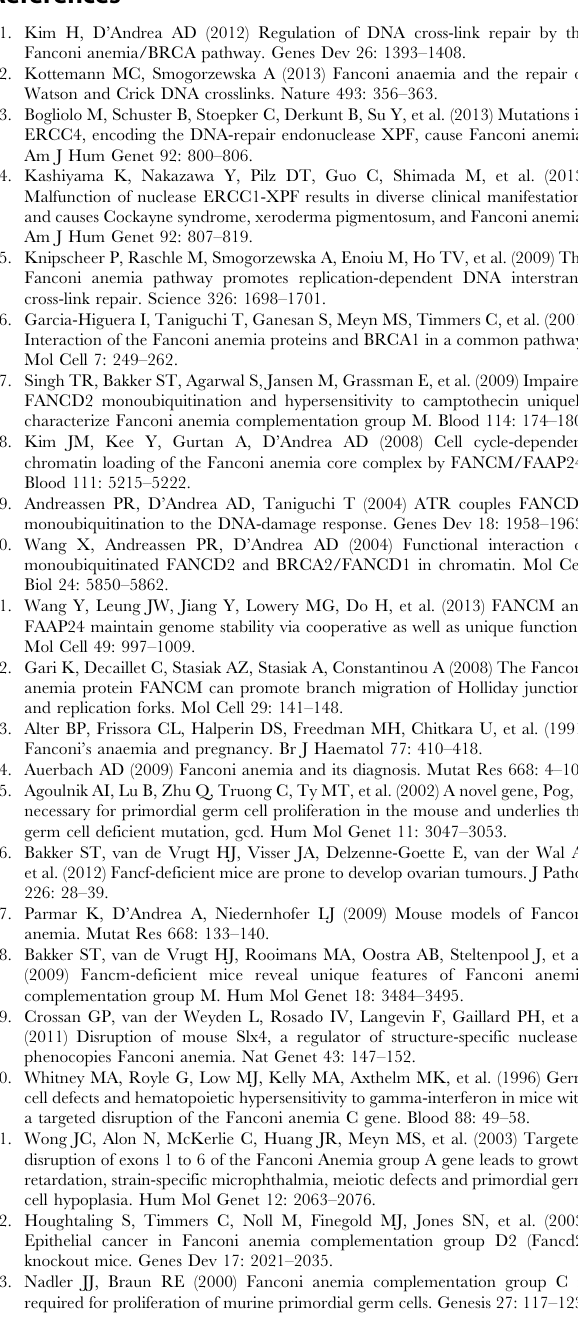
Figure S2 Representative images for PGC quantification and proliferation in E13.5 embryonic gonads. Wild type (A, C) and Fancm C4/C4 (B, D) male (A, B) and female (C, D) gonads are immunolabeled for Stella, a PGC marker, in red and BrdU in green. Figure S3 TUNEL assay of PGCs in E12.5 gonads. Wild type (A, C) and Fancm C4/C4 (B, D) female (A, B) and male (C, D) gonads are immunolabeled for Stella, a PGC marker, in red and TUNEL in green. (E) Atm 2 / 2 testis was used as a positive control for TUNEL signal (green).